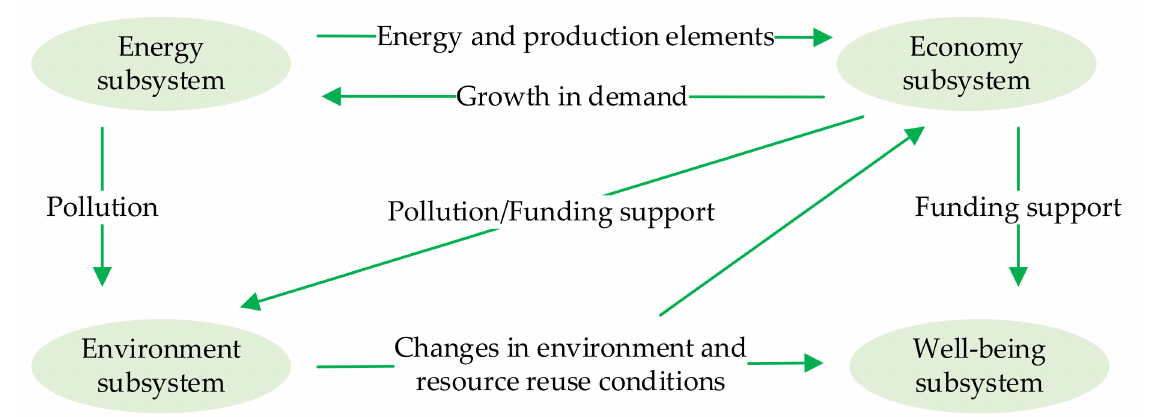
Figure 1. Multi-system network relationships of urban energy utilization